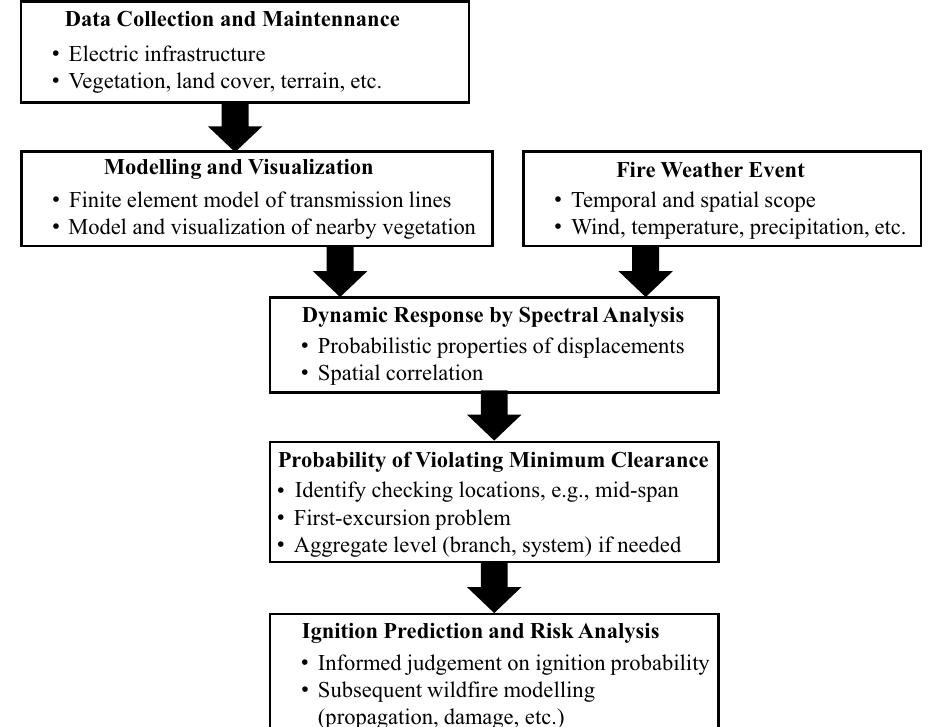
Figure 2. Framework of the proposed methodology (Note that the last box is provided for context but not included in the analysis).